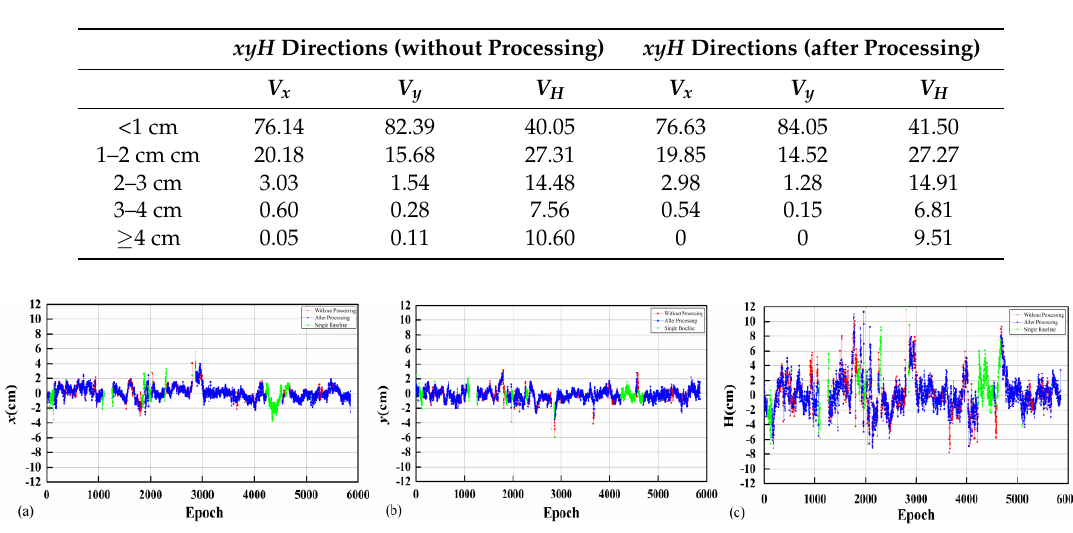
Figure 7. Differences in position in relation to the coordinate time series of the monitoring point: ( a ) x direction; ( b ) y direction; ( c ) H direction. Table 6. Statistics of differences in position in relation to the coordinate time series of the monitoring point (%).